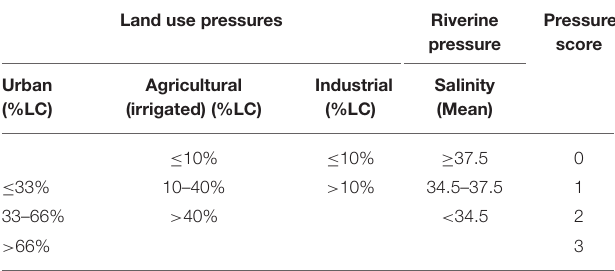
TABLE 2 | Pressures categories and their scores used to calculate LUSI.